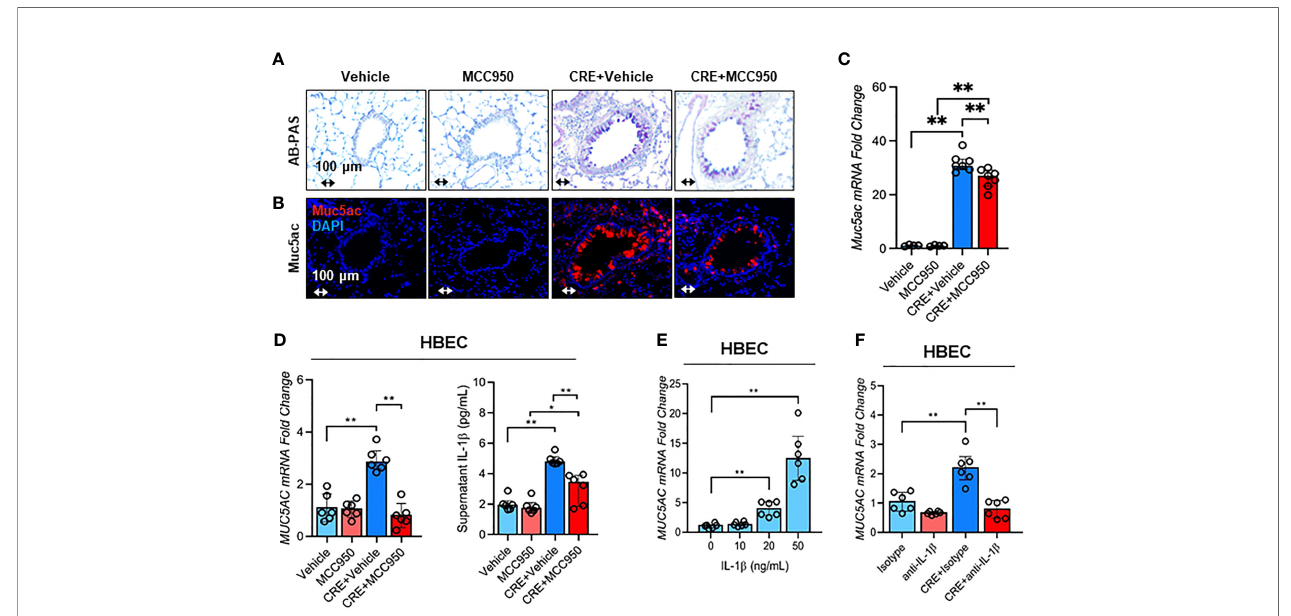
FIGURE 8 | Inhibition of NLRP3 in fl ammasome suppresses cockroach allergen-induced MUS5AC expression. (A) Histological examination of mouse paraf fi n lung sections WITH AB-PAS staining. (B) Representative immuno fl uorescence images of Muc5ac expression in the lung tissues of CRE-induced mouse model of asthma with or without MCC950 treatment. (C) RT-PCR analysis of Muc5ac expression in the lung tissues of CRE-induced mouse model of asthma with or without MCC950 treatment (n = 6). (D) RT-PCR analysis of Muc5ac and ELISA analysis of IL-1 b level in CRE-treated HBECs in the presence or absence of MCC950 (n = 6). (E) RT- PCR analysis of Muc5ac in HBECs treated with IL-1 b at different concentrations (n = 6). (F) , RT-PCR analysis of Muc5ac in CRE-treated HBECs in the presence or absence of anti-IL-1 b (n = 6). Data represent as medians with interquartile (IQR). * p < 0.05, ** p <